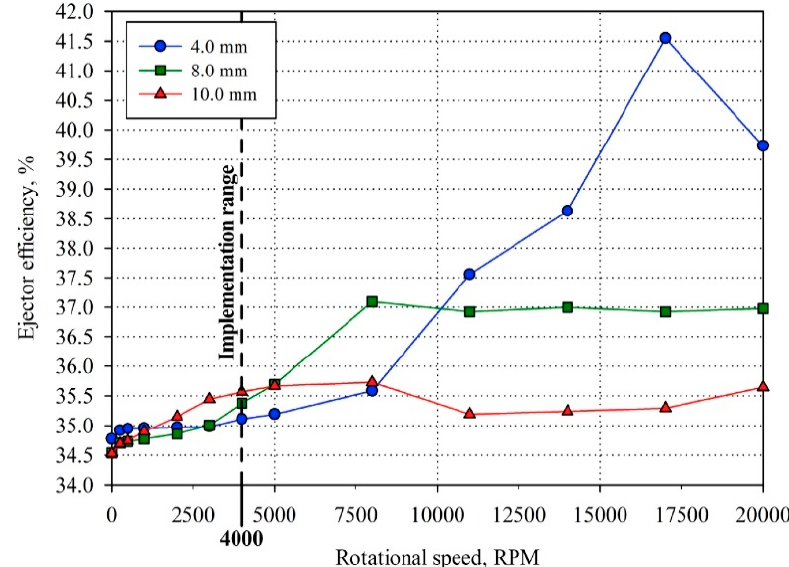
Figure 4. The ejector efficiencies for the unit with different diameters (mm) and rotational speeds (RPM) at the inlet duct of the motive nozzle. Reproduced with permission from [96]. Elsevier, 2016.